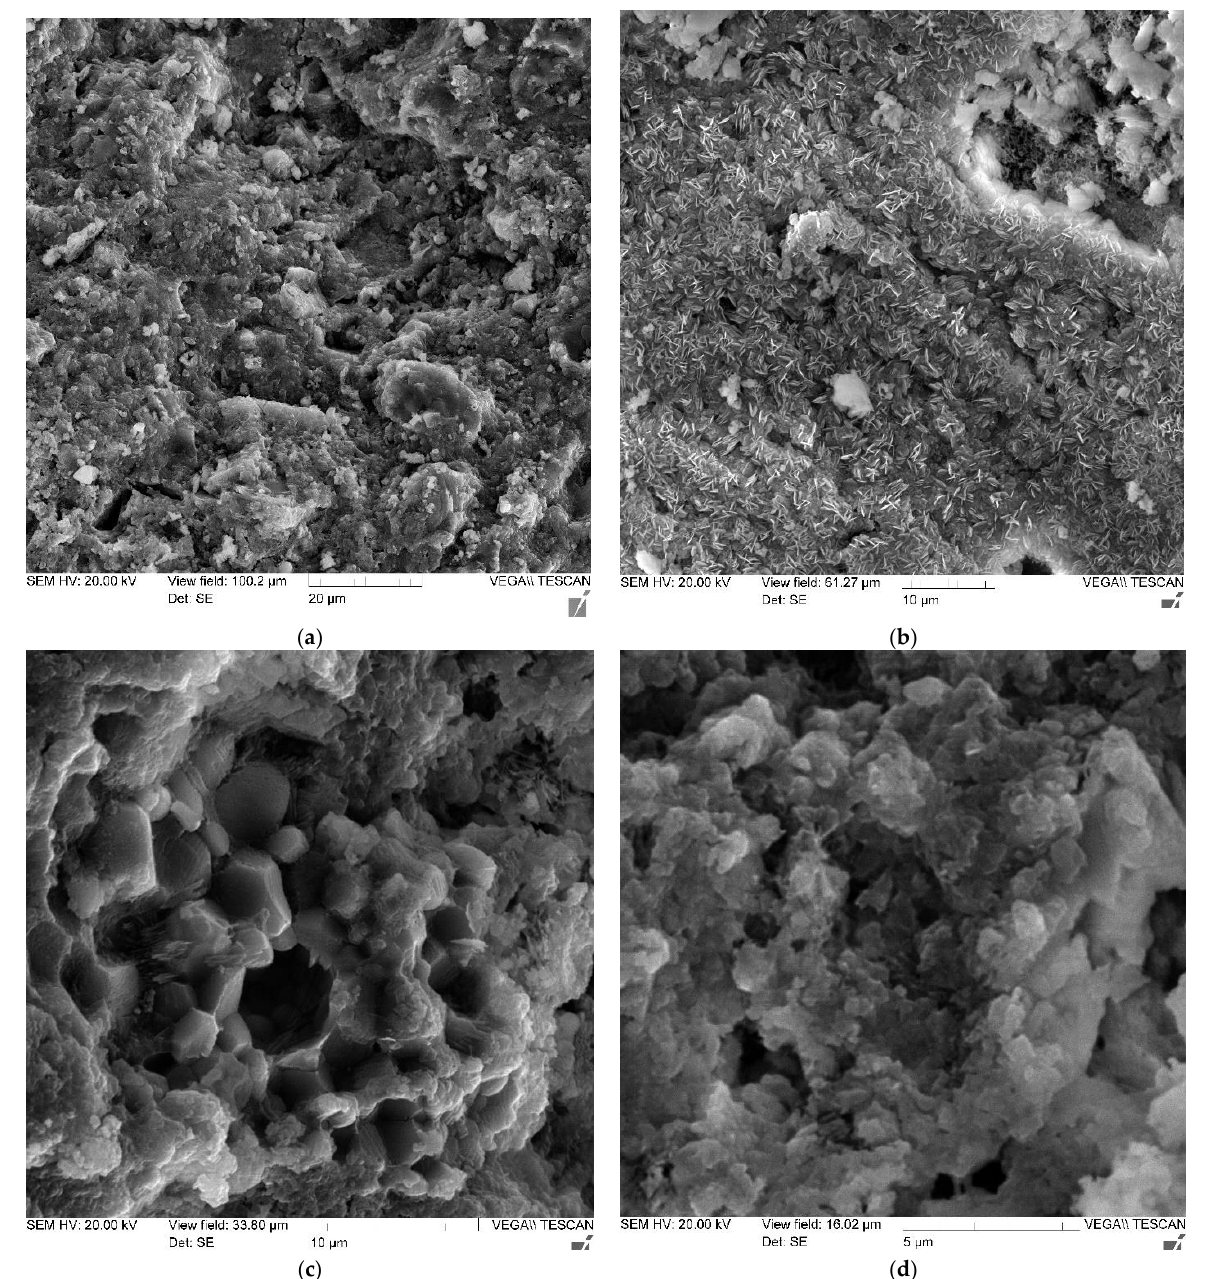
Figure 9. Photographs of the microstructure of micro silica-modified samples with magnification: ( a ) 1000×; ( b ) 2000×; ( c ) 3000×; ( d ) 7000×.